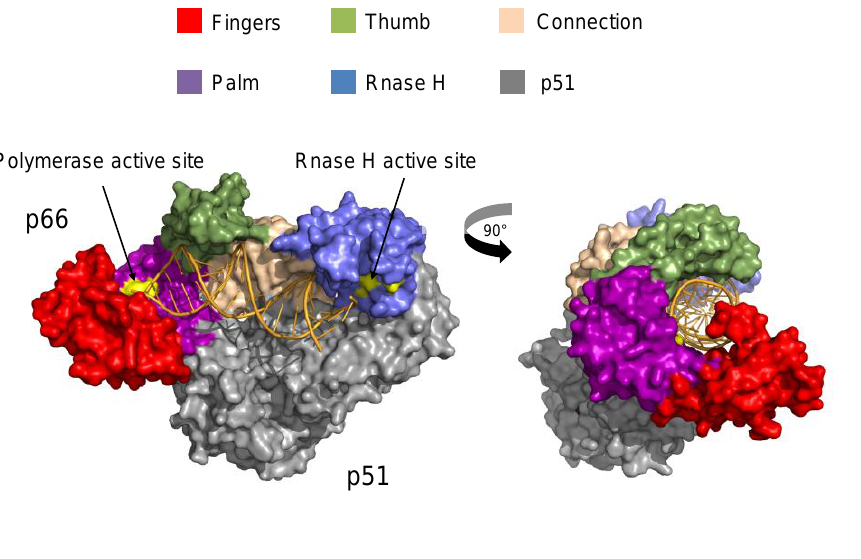
Figure 2. Structure of reverse transcriptase (RT). RT is pictured as a solvent-accessible surface area model (taken from PDB ID: 1RTD). The DNA/DNA template/primer is shown as a cartoon. The p51 subdomain is colored in grey, and the p66 subdomain is subdivided into thumb (green), fingers (red), palm (purple), connection (wheat) and RNase H (blue) domains. The polymerase and RNase H active site residues are colored in